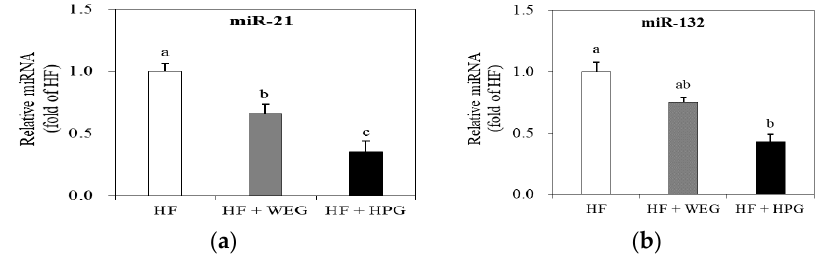
Figure 6. Effects of WEG and HPG on microRNA(miR)-21 and miR-132 in WAT. The levels of ( a ) miR-21 and ( b ) miR-132 were measured using real-time qPCR. Values are expressed as mean ± SEM ( n = 9/group). a,b Mean values with unlike superscript letters are statistically different at p < 0.05. HF: high fat; WEG: hot water extract of ginger; HPG: high-hydrostatic pressure extract of ginger.